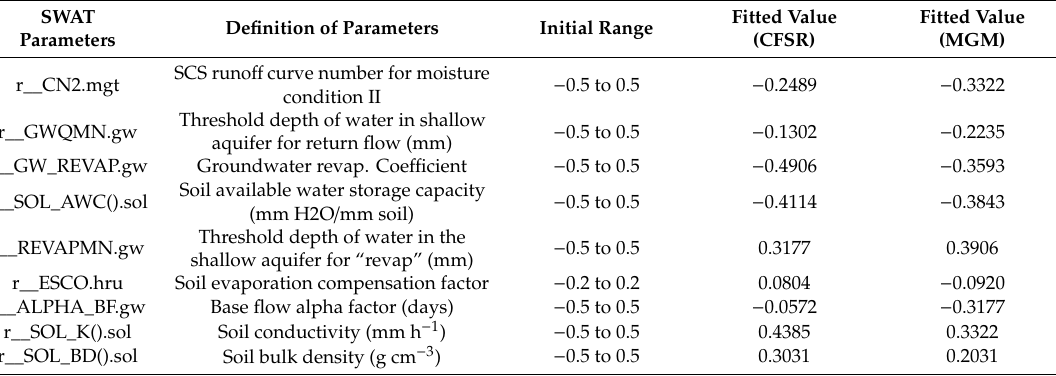
Table 3. Selected Soil and Water Assessment Tool (SWAT) parameters for calibration and their initial range (Term “r__” was used for the relative changes in the parameter according to the given interval, “()” was used for all layers of soil and extension of the parameter states the file name of the